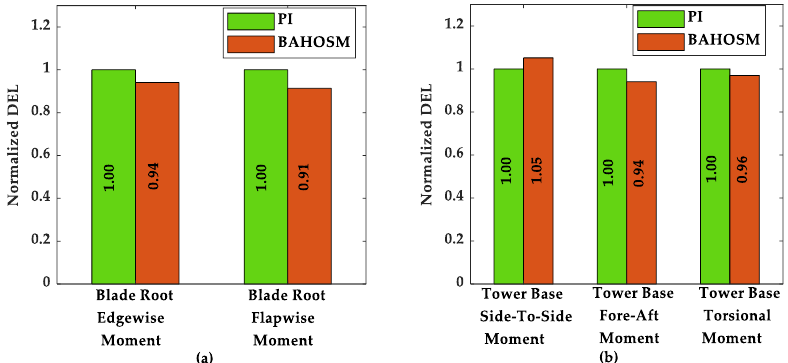
Figure 9. Normalized DEL of the blade root ( a ) and the tower base ( b ) in Case 1.